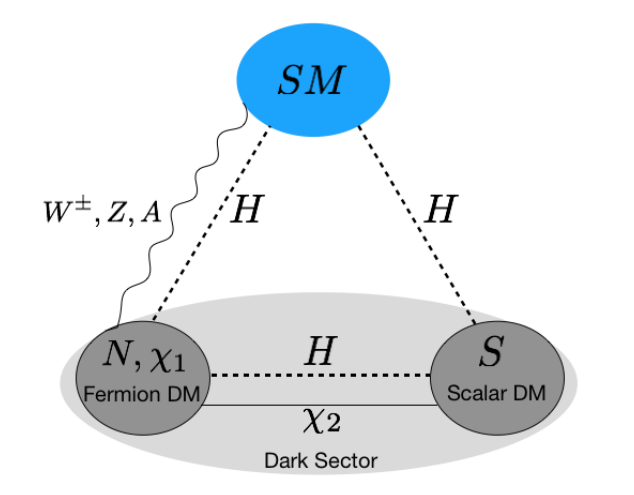
Figure 1 . Schematic diagram showing the interactions between scalar and fermion DM components and that to SM particles.